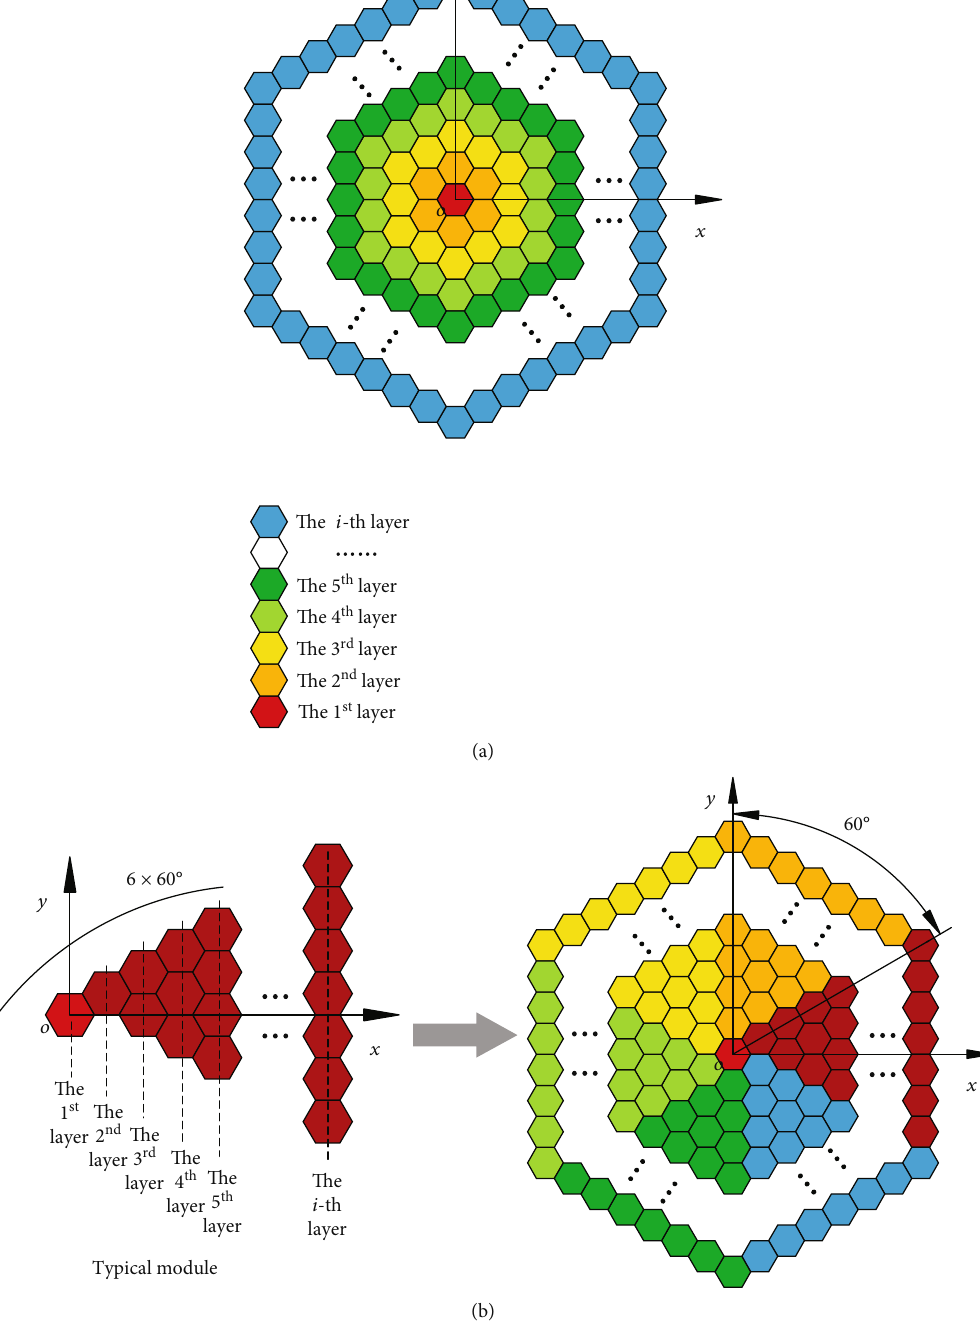
Figure 8: Module topology laws. (a) Hierarchical topology. (b) Toroidal